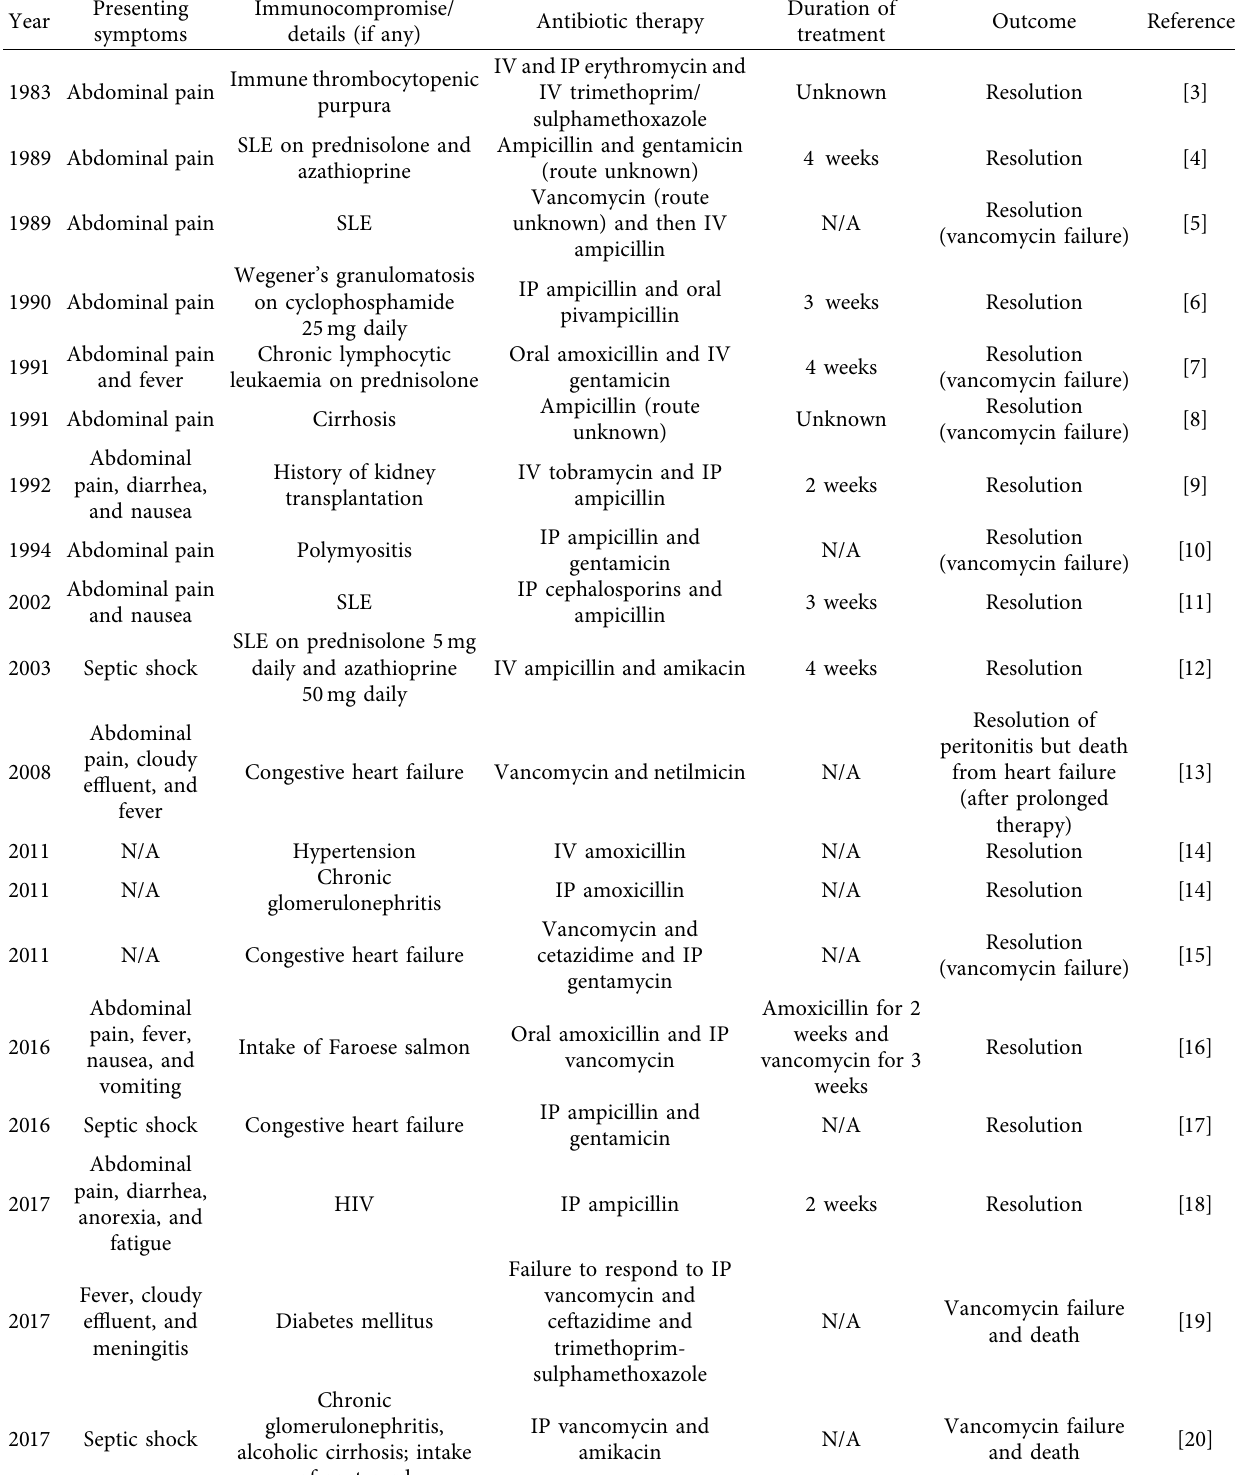
Table 1: Nineteen reported cases of CAPD-related peritonitis caused by Listeria